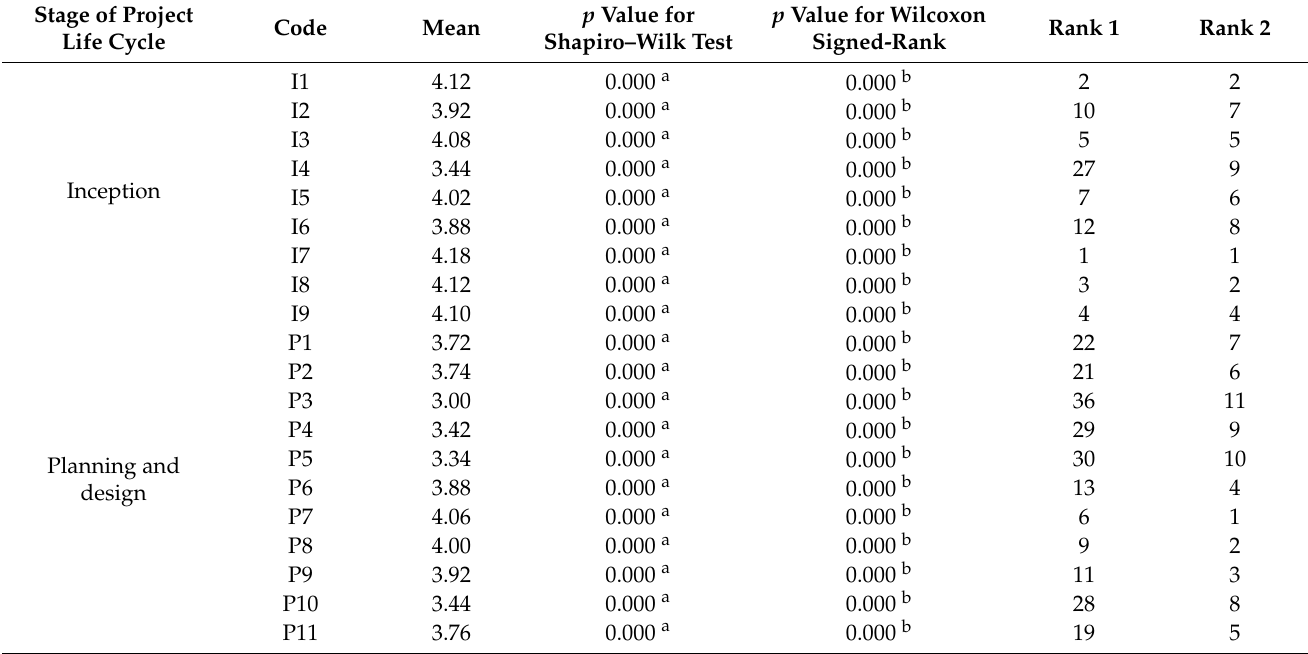
Table 5. Perceived importance analysis of